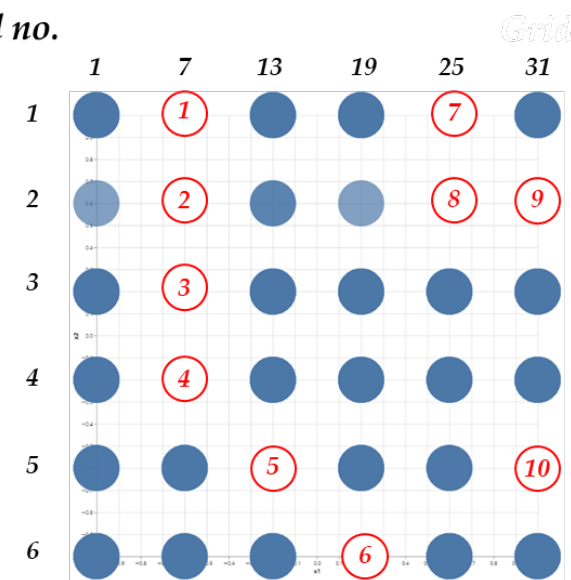
Figure 5. The generative topographic mapping (GTM)-based patent map.